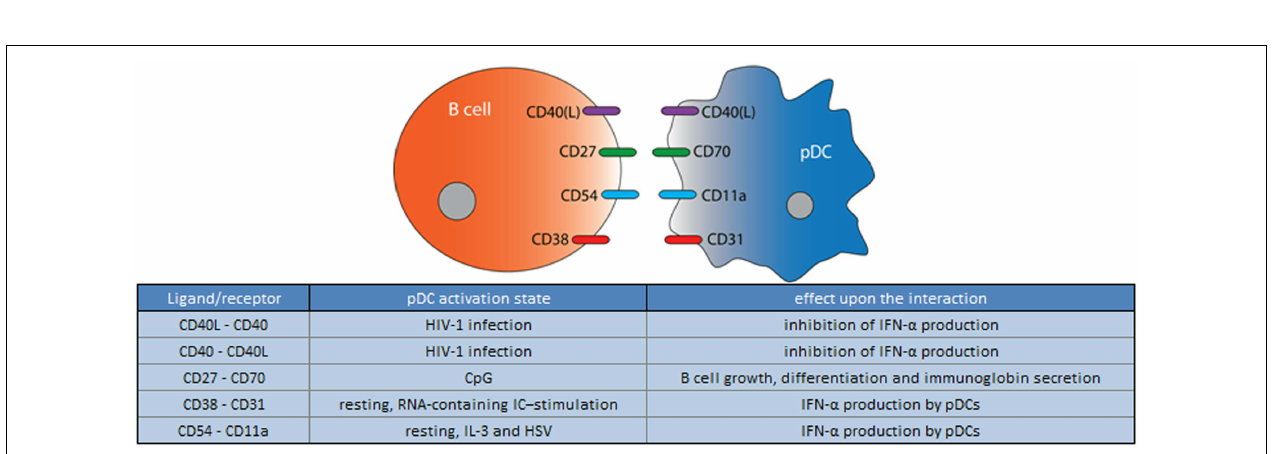
FIGURE 5 | Ligand/receptor paring of a pDC with a B cell and the maturation state/activation stimuli associated with ligand or receptor expression on the pDC surface